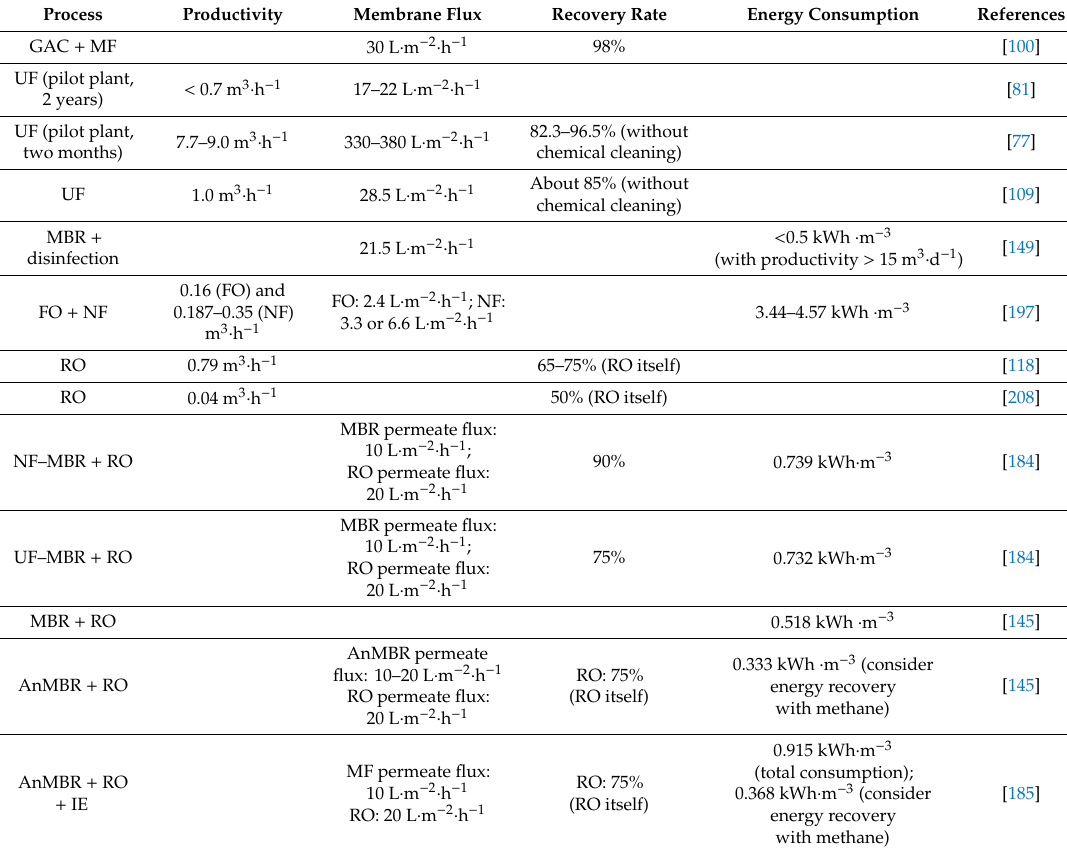
Table 13. Wastewater recovery rate and energy consumption of membrane-based